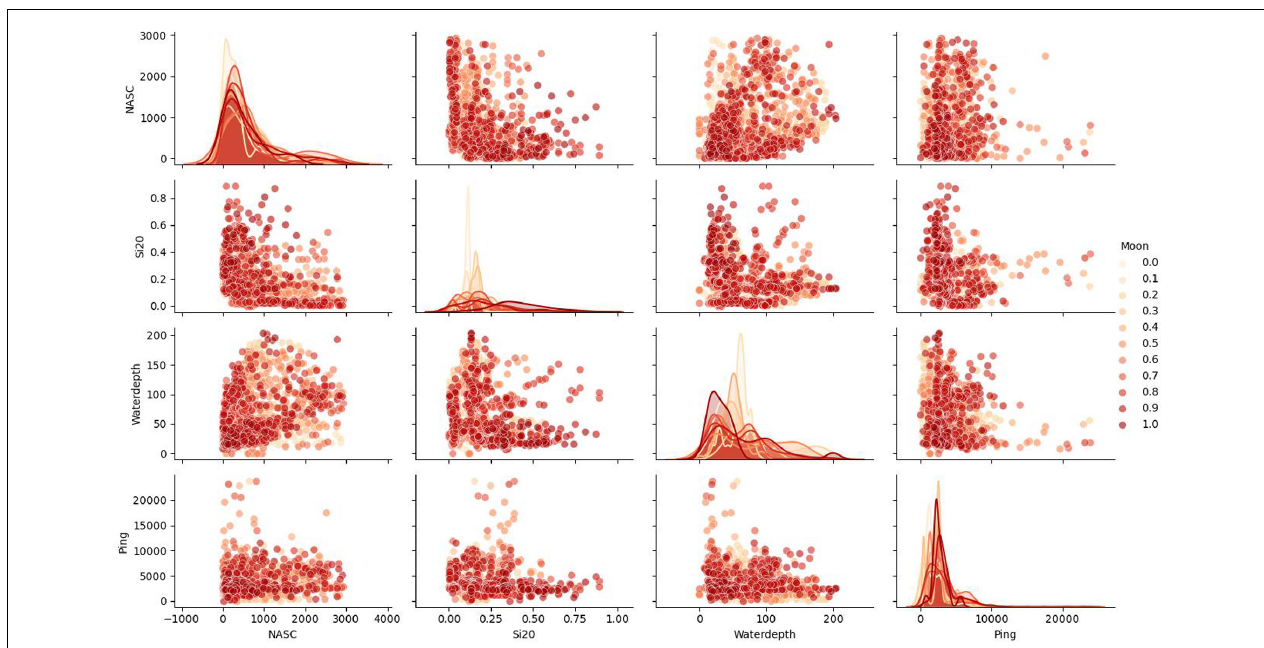
FIGURE 9 | The scatter distribution of the nautical area scattering coefficient (NASC) and main factors, and the diagonal diagram is the distribution curve of each factor in different moon phase perfections. The color of the dot or line gradually deepens with the increase of the moon’s degree of